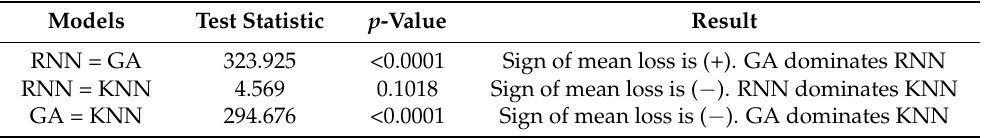
Table 9. Model comparisons: Giacommini–White